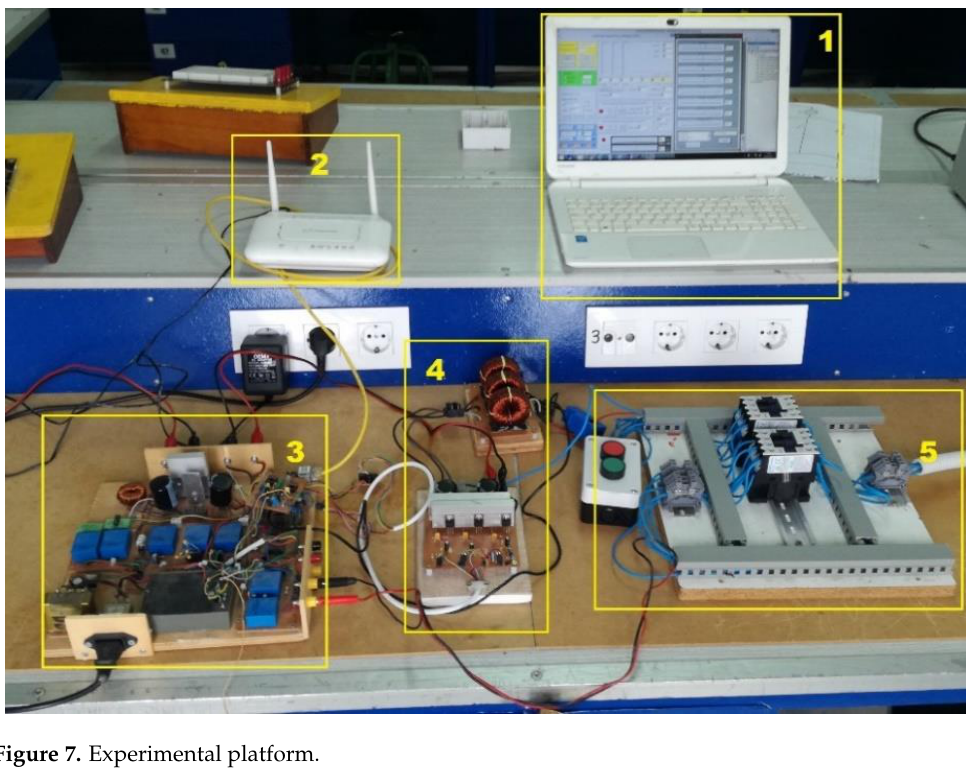
Figure 7. Experimental platform.